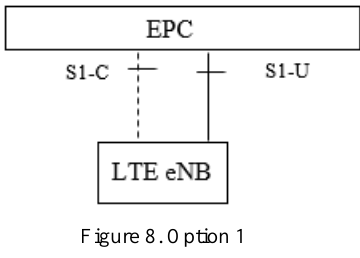
Figure 8. Option